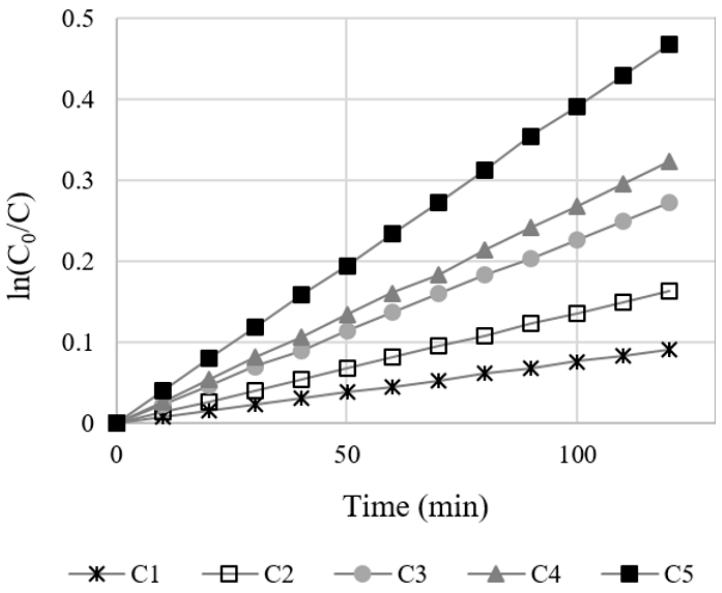
Figure 6. Time versus log of the ratio of concentration relationship.